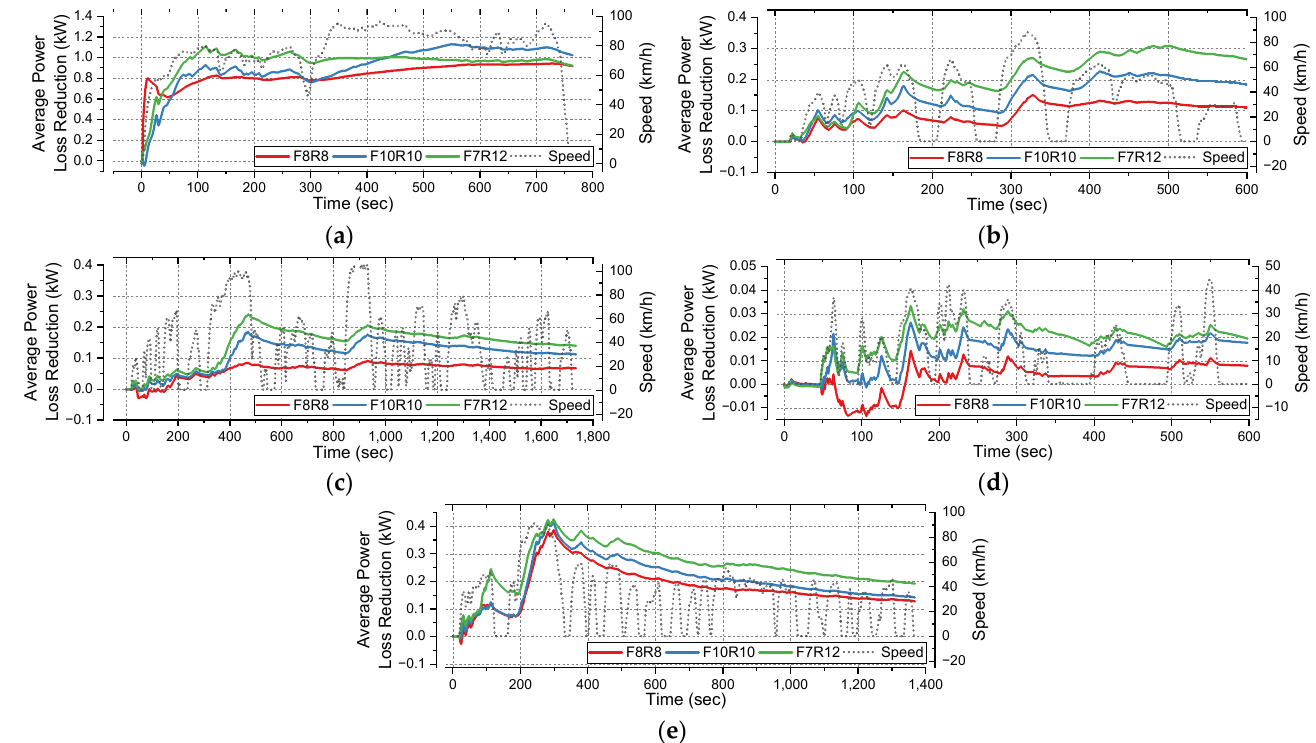
Figure 12. Loss-reduction and average-loss-reduction of drive motor power in five driving cycles using a reduction ratio of 10:1 for the front and rear wheels: ( a ) HWFET, ( b ) SC03, ( c ) LA92, ( d ) NYCC, ( e ) UDDS.